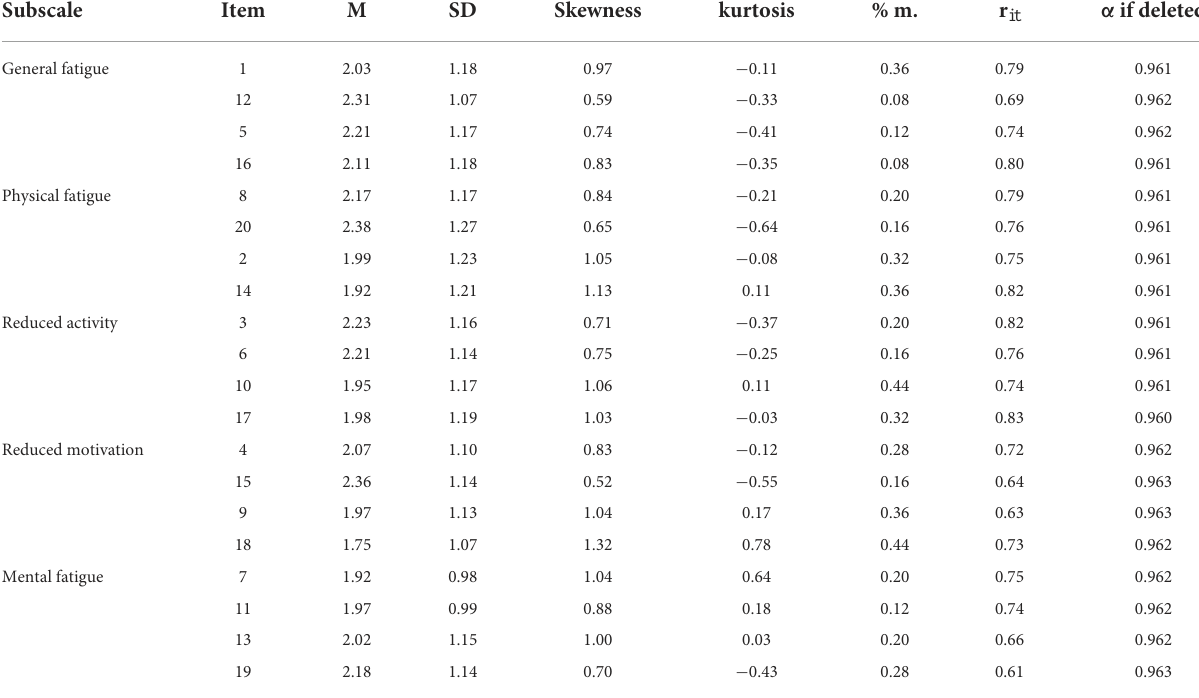
TABLE 2 Item characteristics of the multidimensional fatigue inventory (MFI-20). Subscale Item M SD Skewness